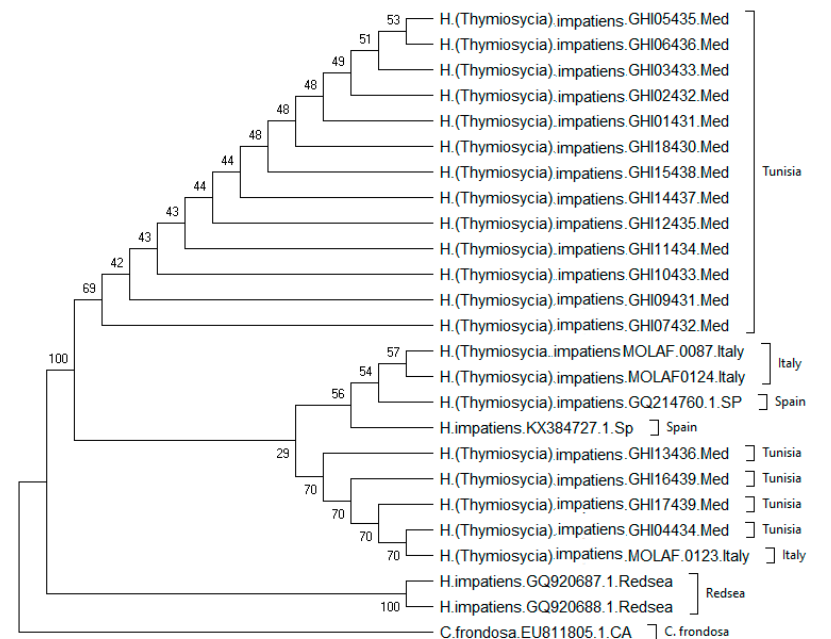
Figure 3. Phylogenetic tree constructed with genetic distances between the individuals based on the method [30], showing the phylogenetic relationships between H. impatiens (a complex of 13 species) deduced from the sequences of the COI fragment of the mitochondrial DNA. Table 4. Pairwise nucleotide p-distances for the COI sequences of Holothuria (Thymiosycia) impatiens . The mean within=group (diagonal) and net average between-groups (below diagonal) divergence. Na: not applicable. Statistically signi fi cant pairs shown in bold ( p < 0.05). Red Sea Mediterranean Tunisia Italy Spain Red Sea 0.0000